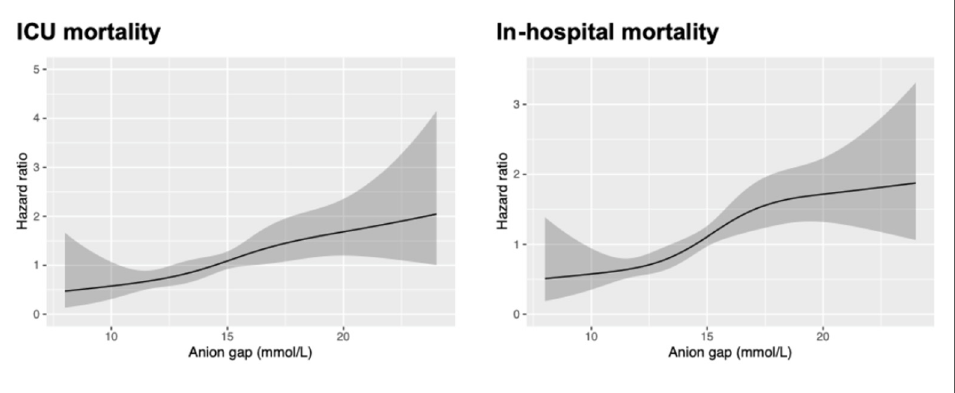
Figure 2. Relationship between the plasma AG and the risk of ICU and in-hospital mortality. Shaded areas around the curves depict 95% confidence intervals. AG: anion gap; ICU: intensive care unit.